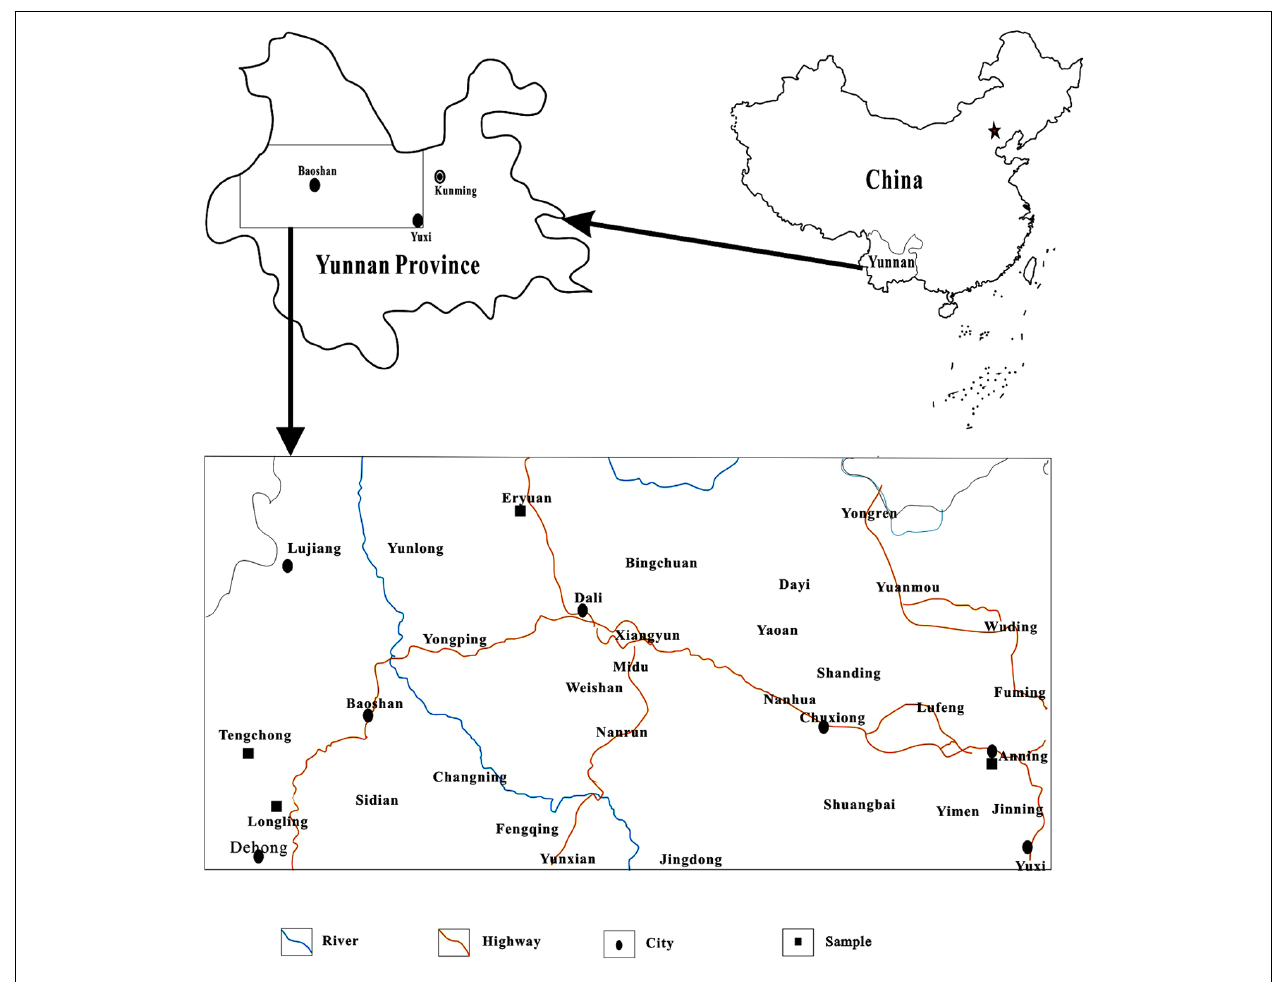
FIGURE 1 |A geographic map of the locations of hot springs inYunnan,